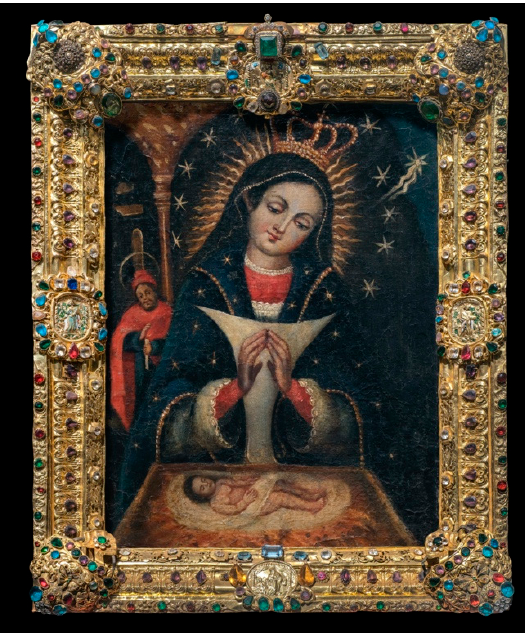
Figure 1. Unknown, Virgen de la Altagracia, oil on panel, c. 1510–1515, Basílica de Nuestra Señora de Altagracia, Higüey, Dominican Republic. Used with permission from Obispado de Higüey. The archbishop’s proclamation of the Virgin of Altagracia’s intercession in favor of a